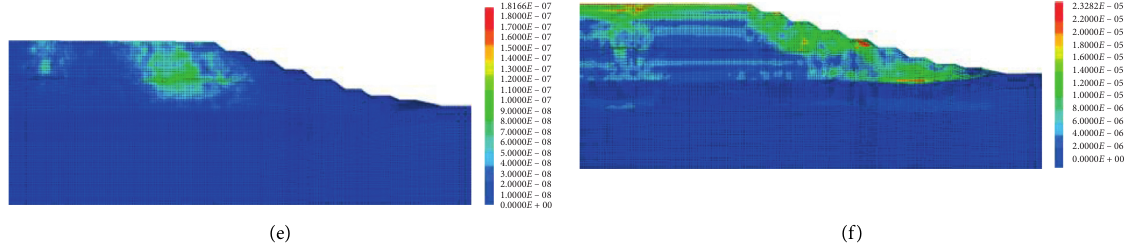
Figure 3: Cloud strain rate cloud map during different horizontal stacking processes. (a) Dumping height +960 m (loading 15 (m). (b) Dumping height +975 m (loading 30 (m). (c) Dumping height +990 m (loading 45 (m). (d) Dumping height +1005 m (loading 60 (m). (e) Dumping height +1020 m (loading 75 (m). (f) Dumping height +1035 m (loading 90